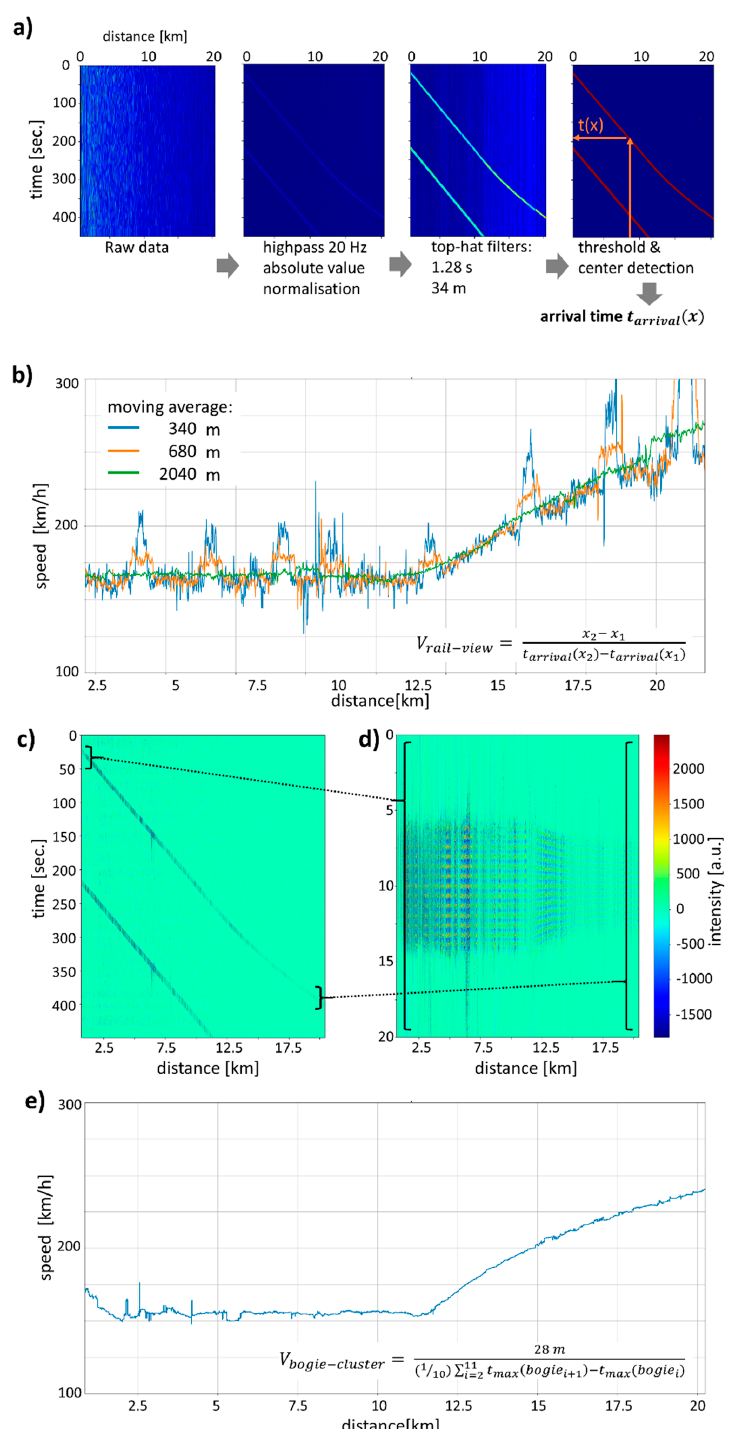
Figure 3. ‘Rail-view’ analysis of the DAS data at fixed positions as a function of time. ( a ) Filtering and center detection are similar to Figure 2a, however, the train arrival time t arrival (x) is determined here. ( b ) From the rail-view data, the train speed is calculated and shown for different averaging lengths. Peaks in the velocity are due to fiber loops. ( c , d ) Arranging the 20 Hz filtered data in ( c ) such that the arrival times are aligned results in a ‘rail-view’ plot ( d ). From the distance of the bogie cluster stripes in ( d ), the bogie cluster velocity is determined ( e